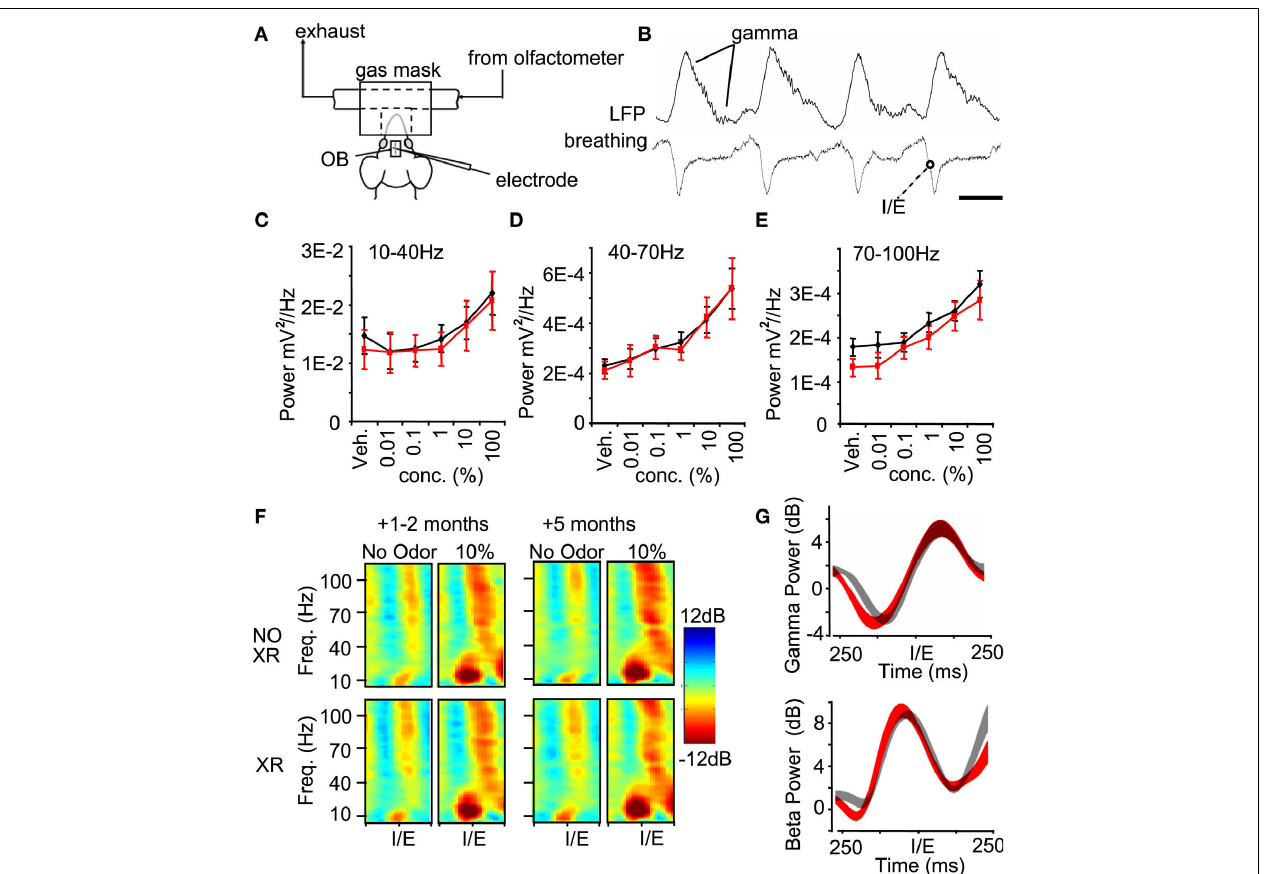
FIGURE 6 | Oscillatory dynamics in the olfactory bulb are unchanged months following a reduction of neurogenesis. (A) In vivo recording paradigm, identical to that in Figure 4 , highlighting the odor delivery apparatus. (B) Local fi eld potential (LFP) traces (top) are recorded alongside the breathing rate (bottom). Gamma frequency (40–100 Hz) oscillations are highlighted emerging after a breath. The transition between inhalation and exhalation (I/E) is used as the trigger for all analyses and odor delivery (Scale = 250 ms). Spectral density of beta (C) , gamma (D) and high gamma (E) LFP oscillations measured after stimulation with increasing concentrations of the odor Amyl Acetate with